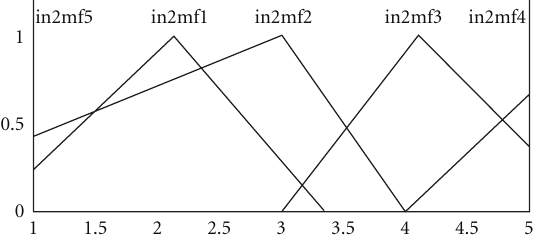
Figure 11: GA ANFIS controller input variable “ ce ”.